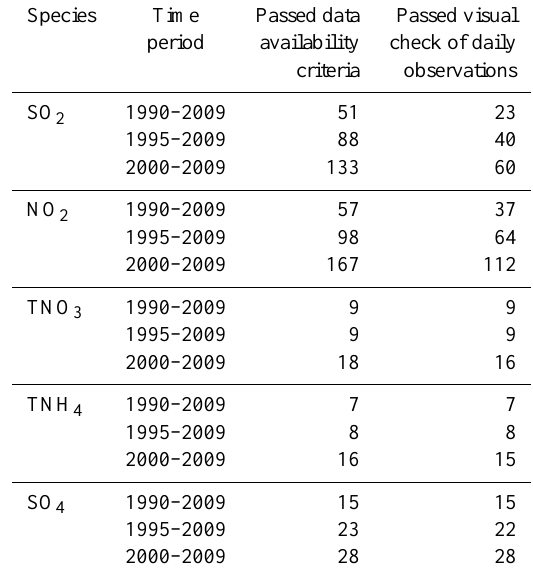
Table 1. Number of stations of the applied observational data set per component and time period before and after the visual screening of the observed time